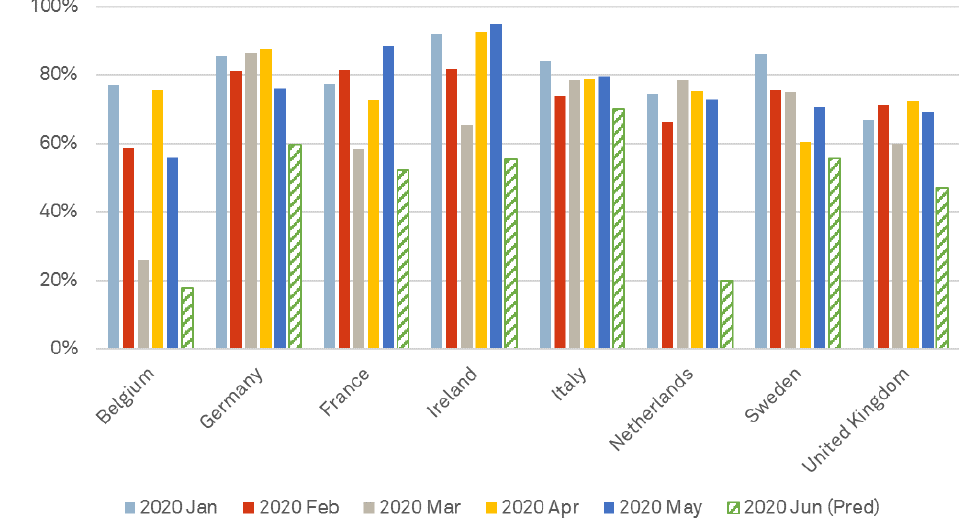
Figure 7. Minimum measures in the COVID-19 situation under the two Figure 8. The percentage of trade credit balances being paid on time in each country(Source: S&P Global Market Intelligence, June 5, 2020. For illustrative purposes only).